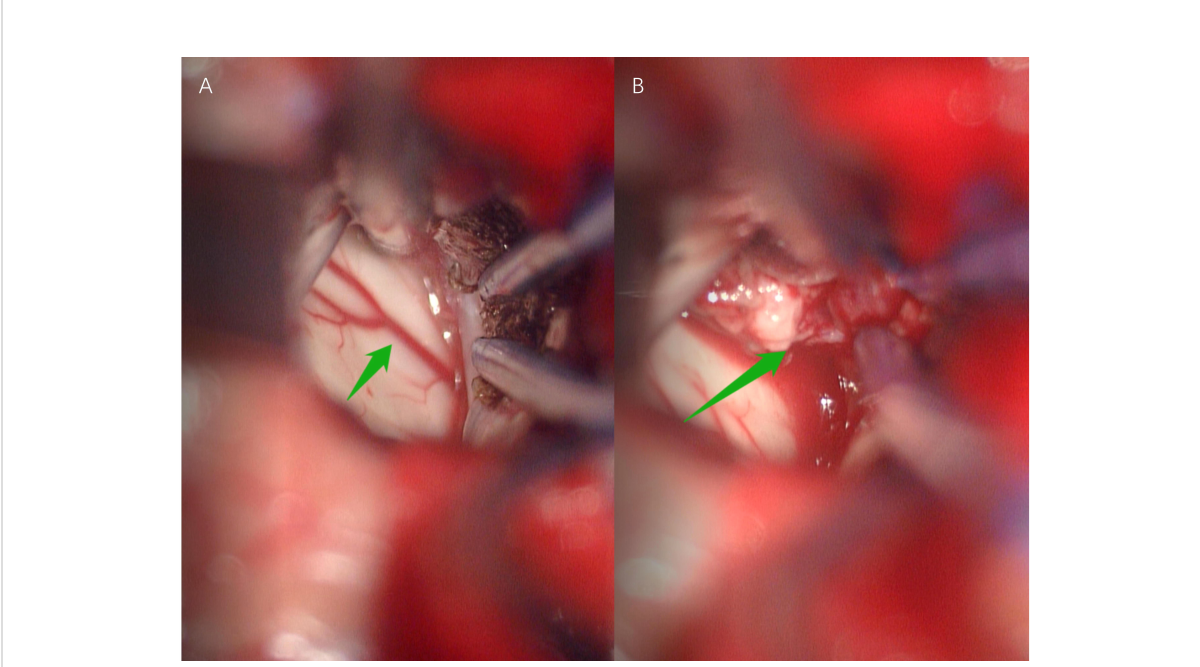
FIGURE 2 Anterior interhemispheric approach for hemangioblastoma. Arrow in (A) Arteria pericallosal. Arrow in (B) Intraventricular tumor with abundant blood supply, unclear boundary and brittle texture